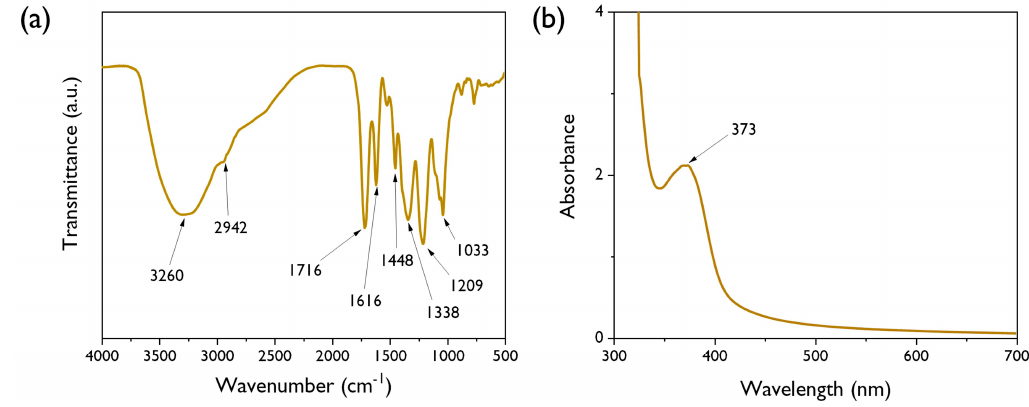
Figure 4. ( a ) FT-IR and ( b ) UV-vis spectra of T. chebula natural dye.